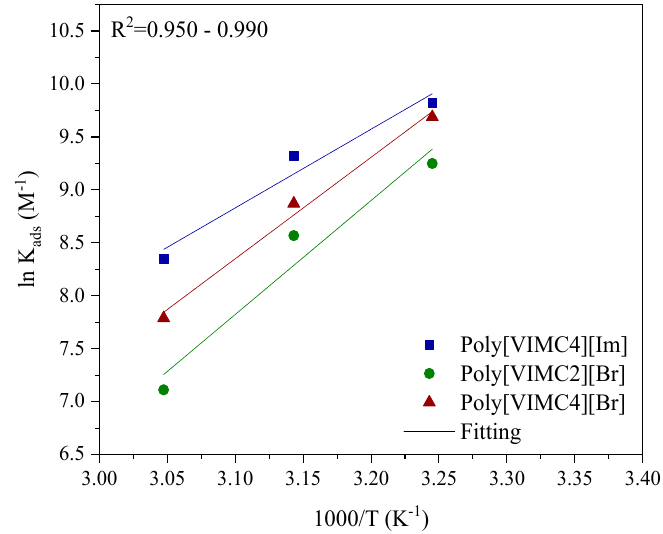
where v corr represents the corrosion rate in g m − 2 h − 1 calculated with i corr values [68] and A is the Arrhenius pre-exponential factor. The kinetic parameters E a and A were obtained Figure 12. Van’t Ho ff plot of API 5L X60 steel exposed to 1 M H 2 SO 4 —CIs. Figure 12. Van’t Hoff plot of API 5L X60 steel exposed to 1 M H 2 SO 4 —CIs. from the slope and ordinate of the origin in Figure 13, respectively. The negative values of ∆ H° ads for the H 2 SO 4 —CI system indicate not only that the adsorption process of Poly[VIMC4][Im], Poly[VIMC2][Br] and Poly[VIMC4][Br] had an exothermic nature, which is characteristic of physical adsorption [65], but also that the spontaneity of the adsorption process is limited by the temperature and that the protection of the metallic surface was favored at 298 K. On the other hand, the negative value of ∆ S° ads reveals that the inhibiting molecules present in the acid-inhibitor electrolytic solution are adsorbed orderly on the surface [66]. The temperature e ff ect on the corrosion inhibition of steel in the presence and absence of PILs can also be studied from the kinetic point of view by employing the Arrhenius equation shown in Equation (8). The activation energy ( E a ) is the energy that is necessary for a chemical reaction to be carried out and is related to the corrosion rate [67]: